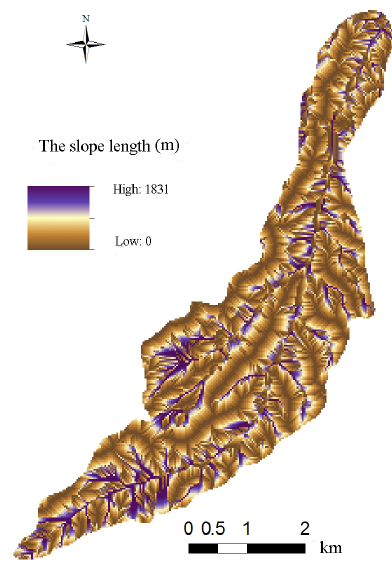
Figure 10. Spatial distribution of LS factor